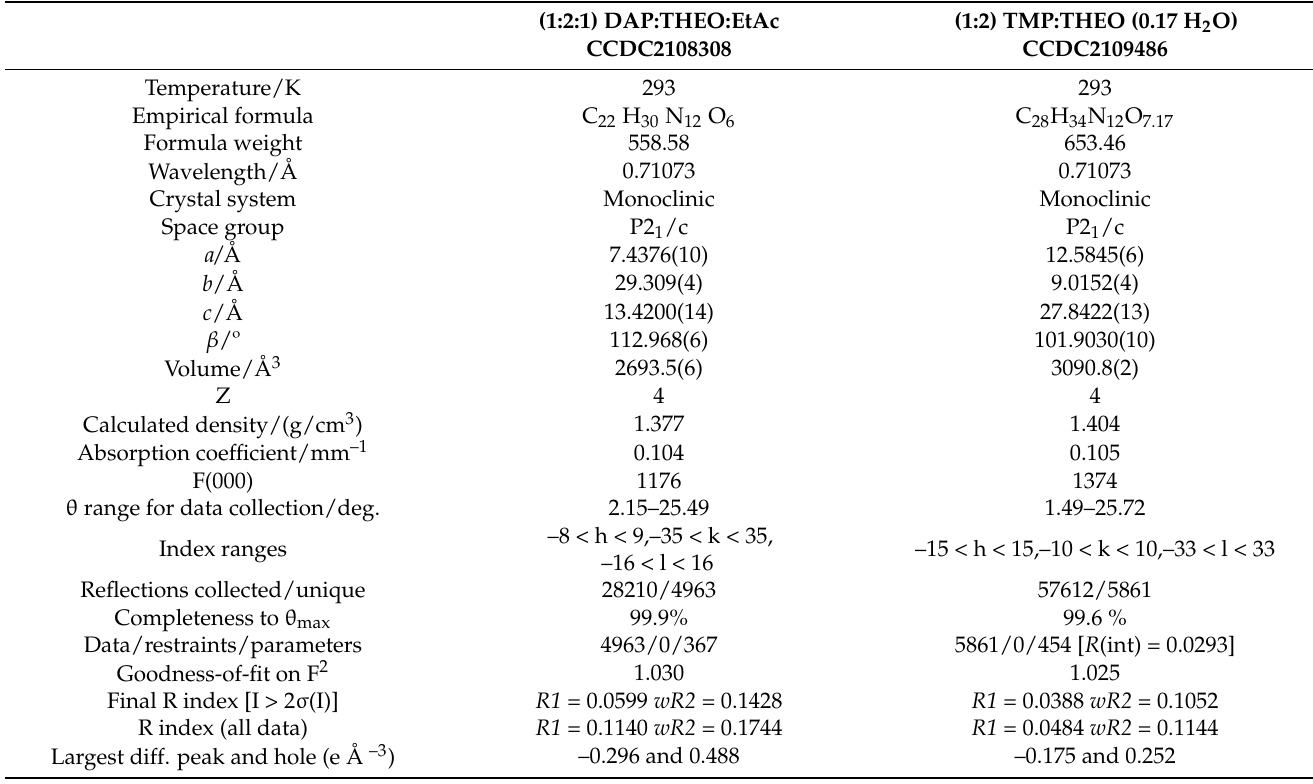
Table 4. Crystal data and structure refinement parameters of the (1:2:1) DAP:THEO:EtAc and (1:2) TMP:THEO (0.17 H 2 O)